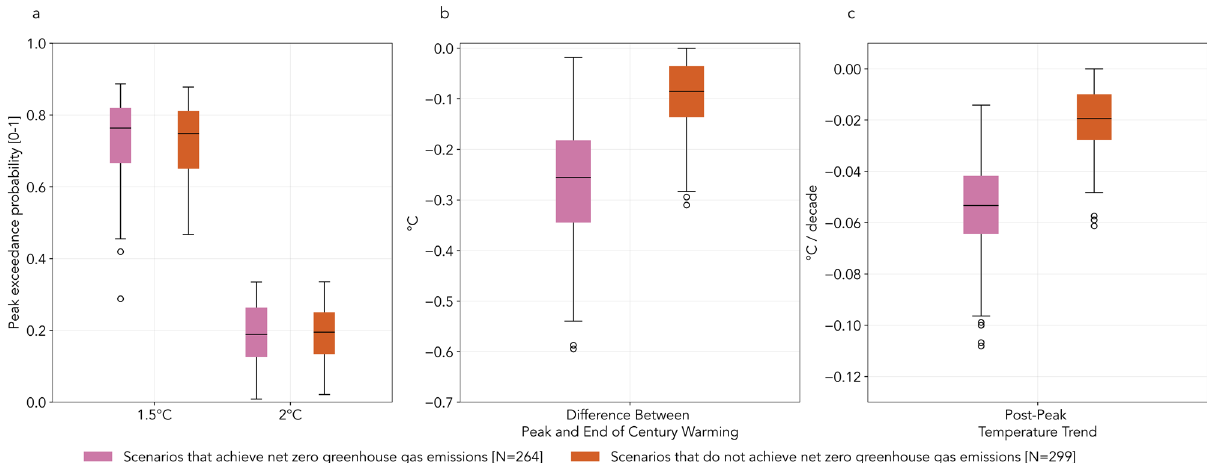
Fig. 2 Emission pathway characteristics and their relation to achieving net zero greenhouse gas emissions. a Peak exceedance probability for 1.5 °C, and 2.0 °C using an 11-year running mean, b Difference between peak and end of century warming, c Decadal temperature trend post peak warming. For b and c , we use the median of the temperature outcomes calculated using an 11-year running mean based on the output from MAGICC7 (see Methods). We include scenarios that fall into the following AR6 WGIII categories: C1 (limit warming to 1.5 °C (> 50%) with no or limited overshoot), C2 (return warming to 1.5 °C (> 50%) after a high overshoot), and C3 (limit warming to 2 °C (> 67%)) (compare Table 1), and group scenarios according to whether they do (pink) or do not achieve (orange) net zero greenhouse gas emissions during the 21st century. The box represents the interquartile range (25th – 75th percentile) and the whiskers represent the range with outlier datapoints (de fi ned as datapoints that lies beyond 1.5 times the interquartile range above the 25th or 75th percentiles) represented as individual